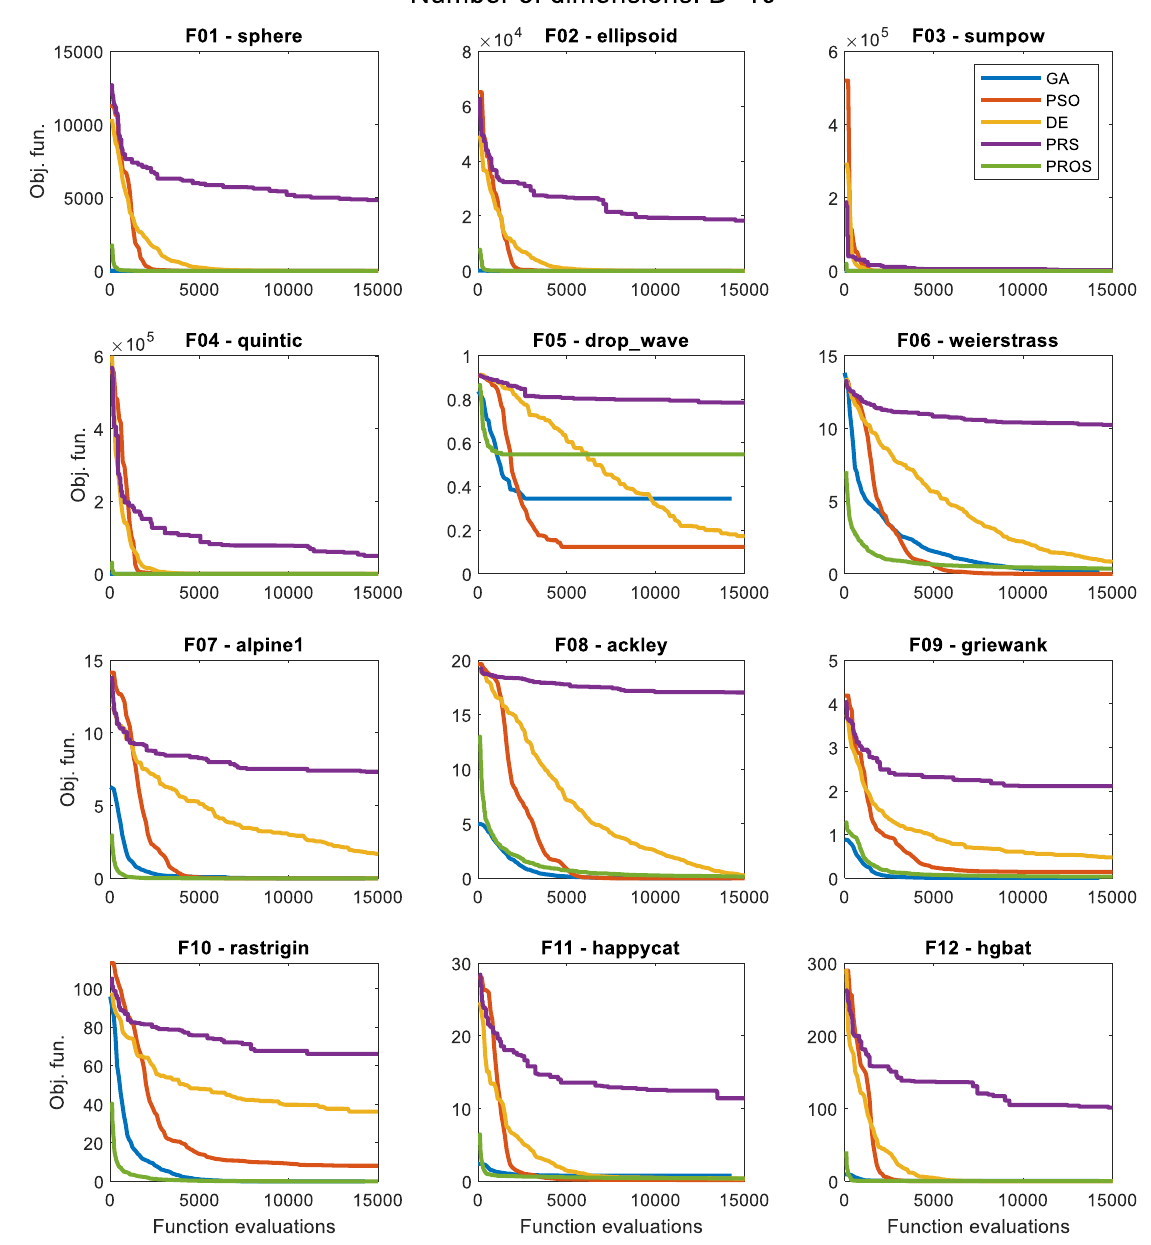
Figure 6. Convergence history of the various optimizers for 10 dimensions ( D = 10), for all 12 objective functions (average of 10 runs).